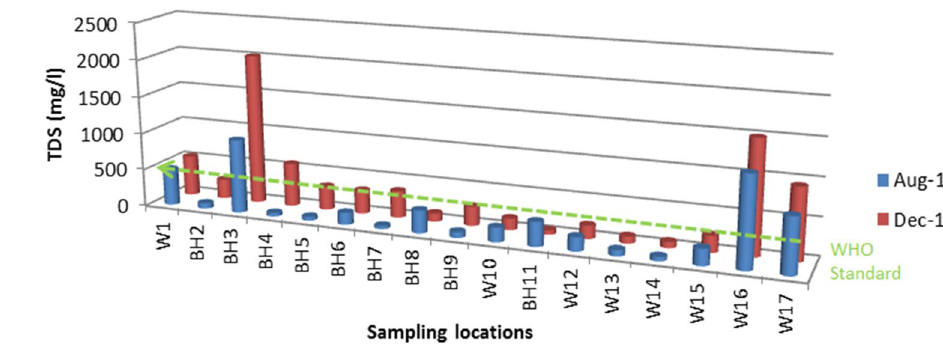
Fig. 7 Seasonal variations in TDS concentration of water sample versus WHO standard